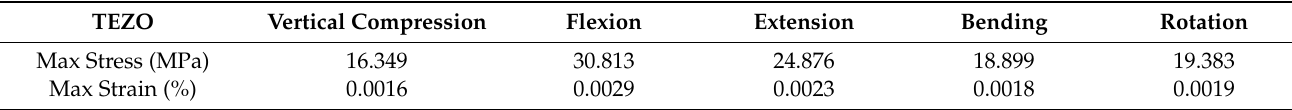
Table 16. The max stress and strain of the TEZO model.